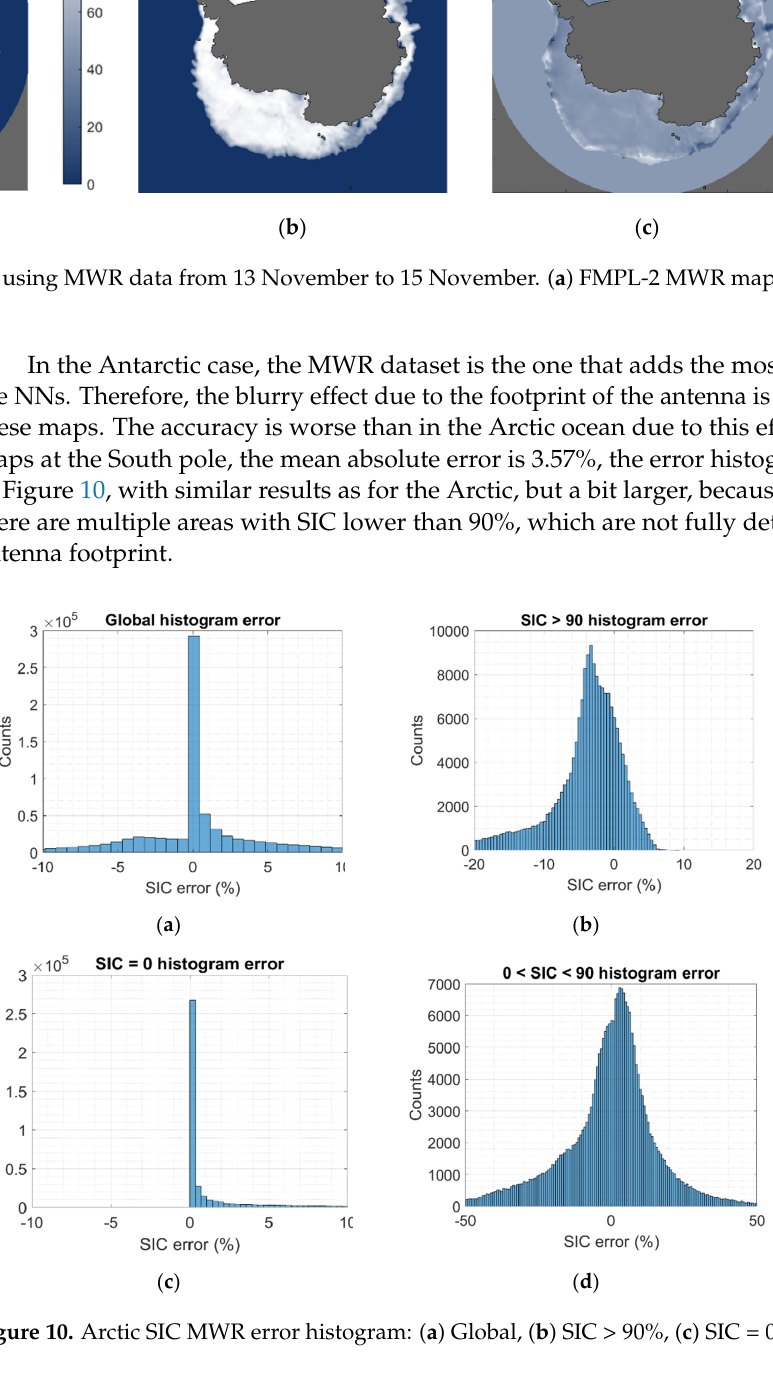
Figure 8. Arctic SIC MWR error histogram: ( a ) Global, ( b ) SIC > 90%, ( c ) SIC = 0 ( d ) 0 < SIC < 90.